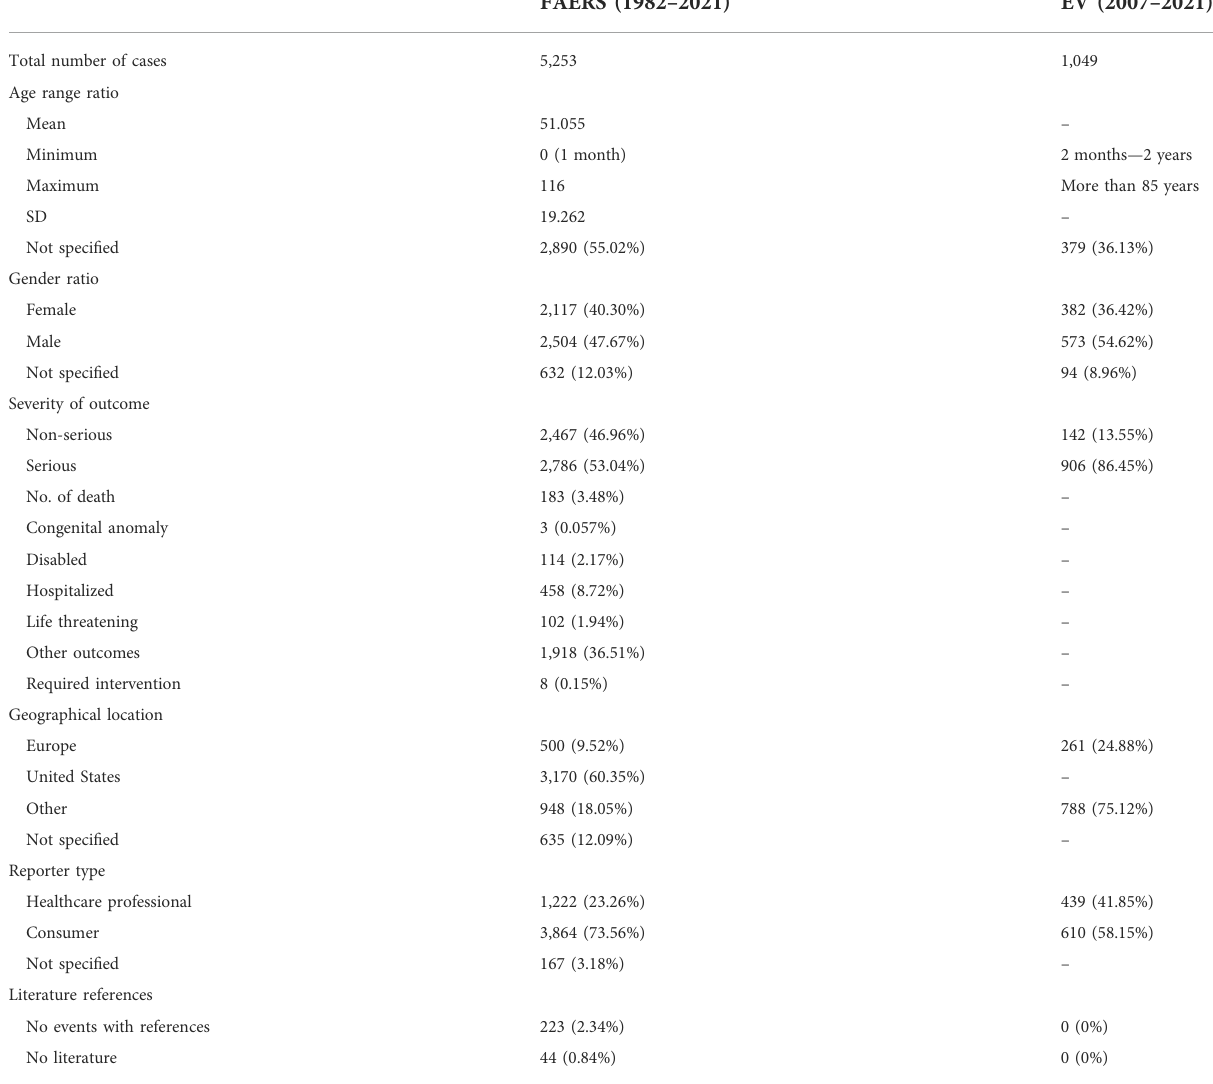
TABLE 1 Summary of the main characteristics of cases identi fi ed in the two pharmacovigilance